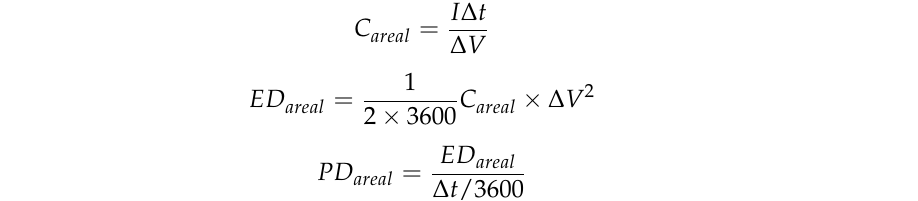
Figure 7. ( a ) Rate capability of the MnO x //MnO x , rGO//rGO, rGO//MnO x -0.6C, rGO//MnO x -0.9C, and rGO//MnO x -1.2C MSCs in terms of ( a ) areal and ( b ) stack capacitances. The areal capacitance, energy and power densities of the MSCs were computed using Equations (1)–(3), respectively